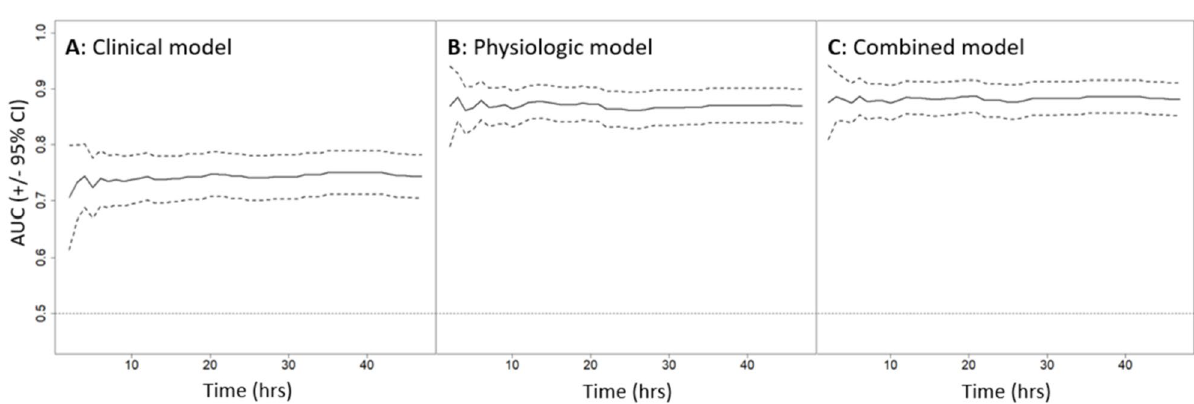
Figure 3. Neurologic decline (ND) prediction model performance based on clinical ( A ), physiologic ( B ), and combined ( C ) predictor variables. Individual receiver operating characteristic (ROC) curves demonstrate model performance for predicting ND at specific times (in hours) from presentation, denoted by line color.